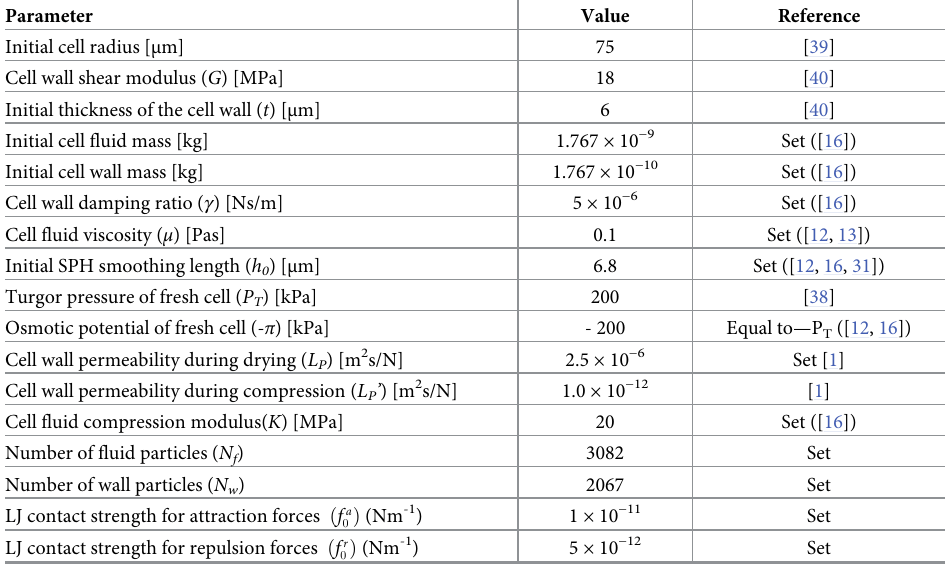
Table 3. Physical, biological and geometrical property values used for the 3-D single cell compression model, rep- resenting an apple cell (Royal Gala apple ( Malus Domestica